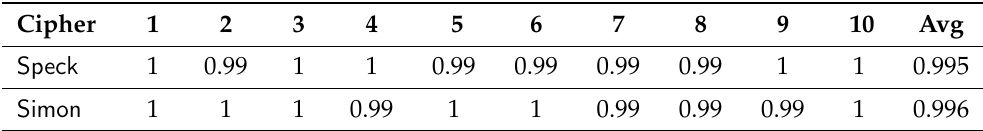
Figure 4. One-shot training and validation accuracy over epochs, for Speck , with a contrastive loss, given the evaluation accuracy of 100%. Table 2. One-shot test accuracies with a contrastive